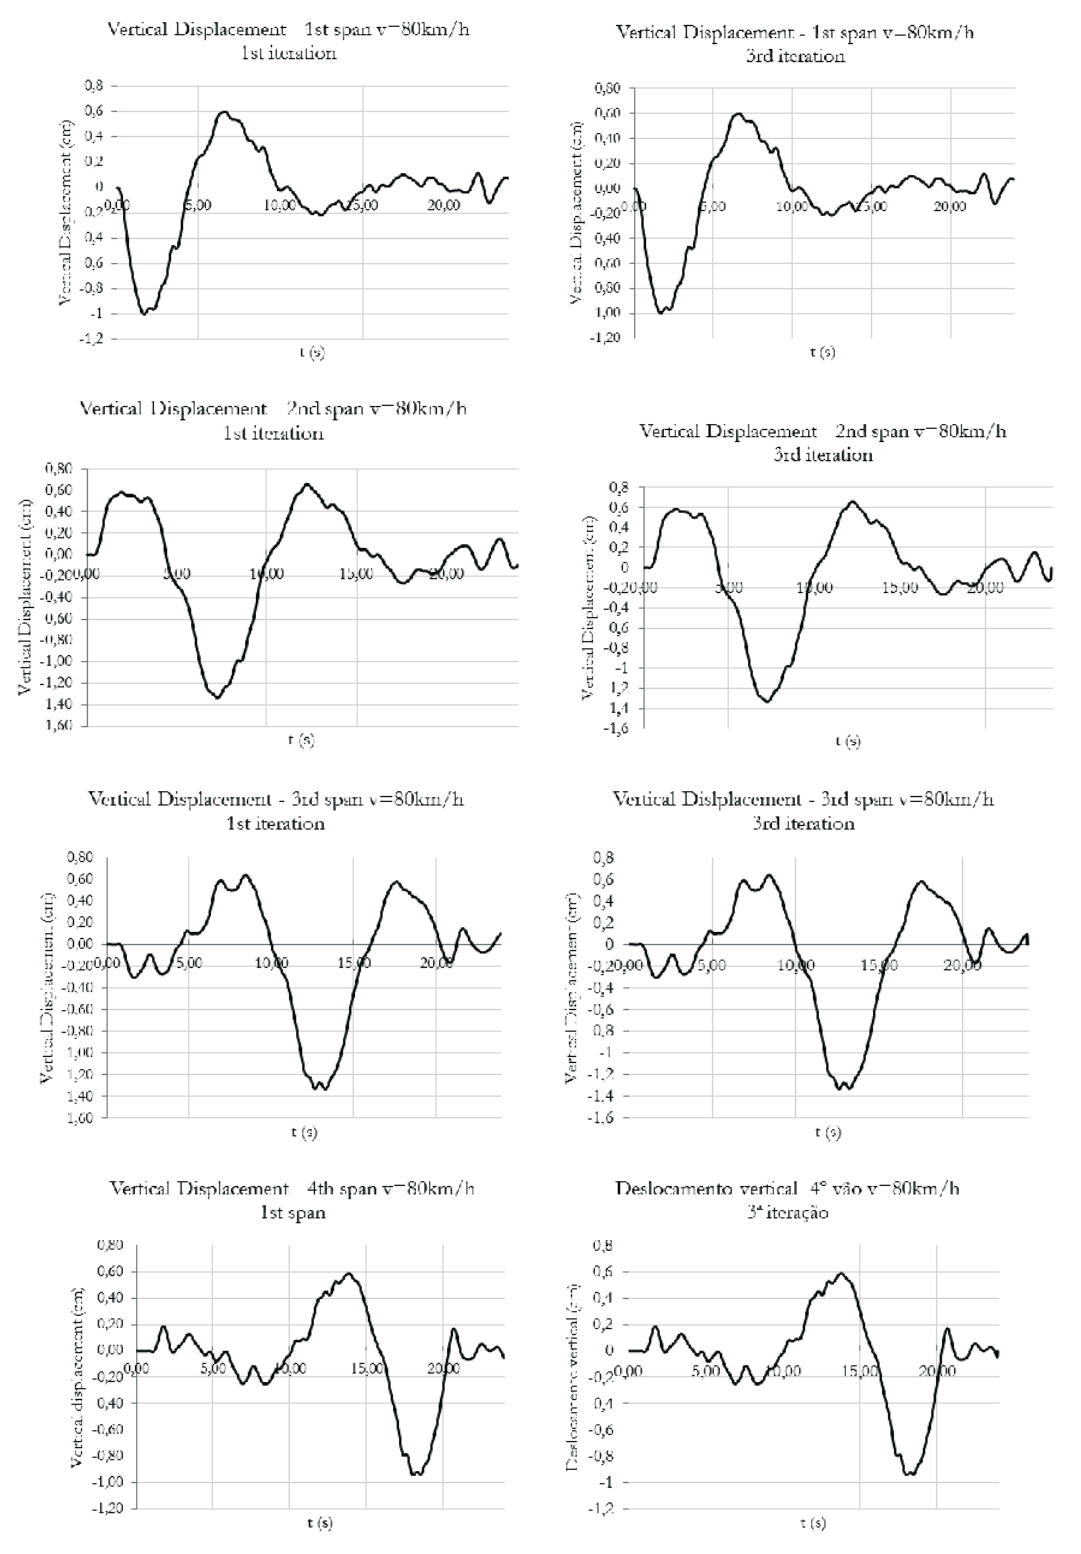
Comparison of displacements between the 1 st and 3 rd iterations –